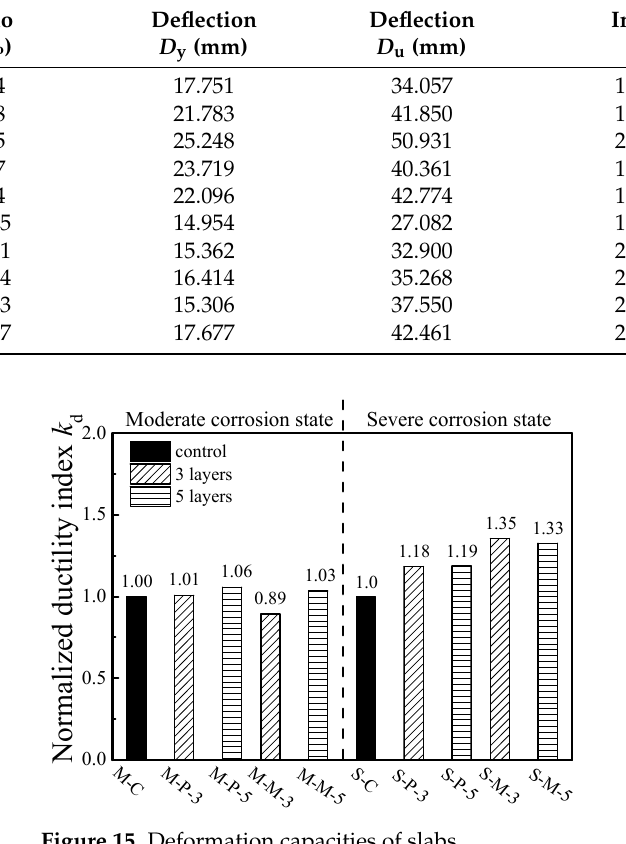
Figure 15. Deformation capacities of slabs. Table 7 lists the maximum deflections of the strengthened slabs at the post-peak stage. The control specimens and M-P-5 failed in a brittle manner after reaching the peak